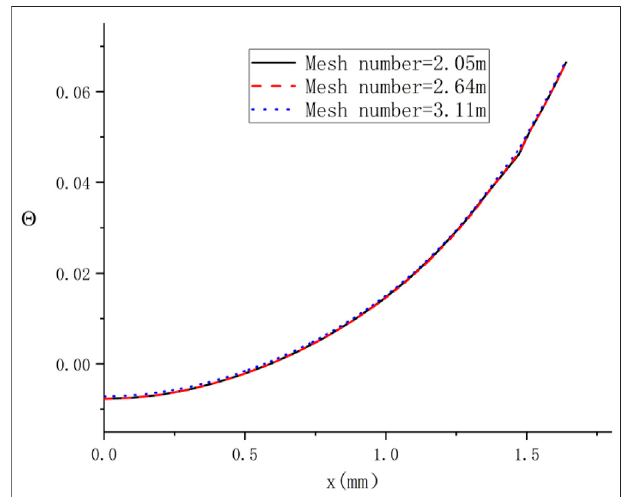
FIGURE 4 | The dimensionless temperature pro fi les along line ab of the three sets of